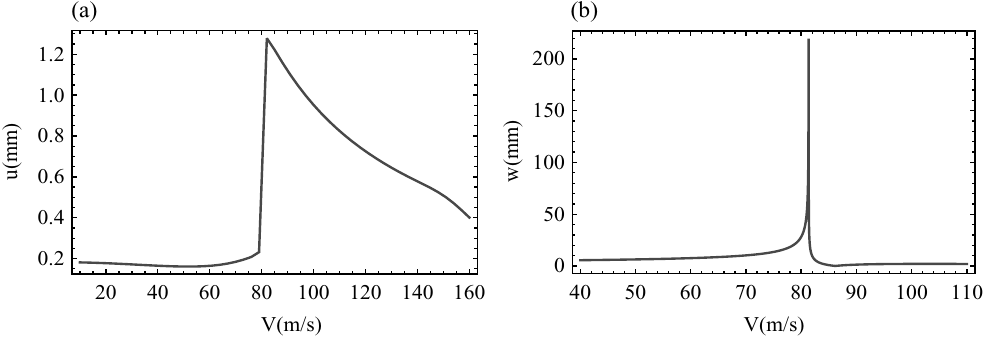
Fig. 4. The maximum displacements: (a) the horizontal component, (b) the vertical component.